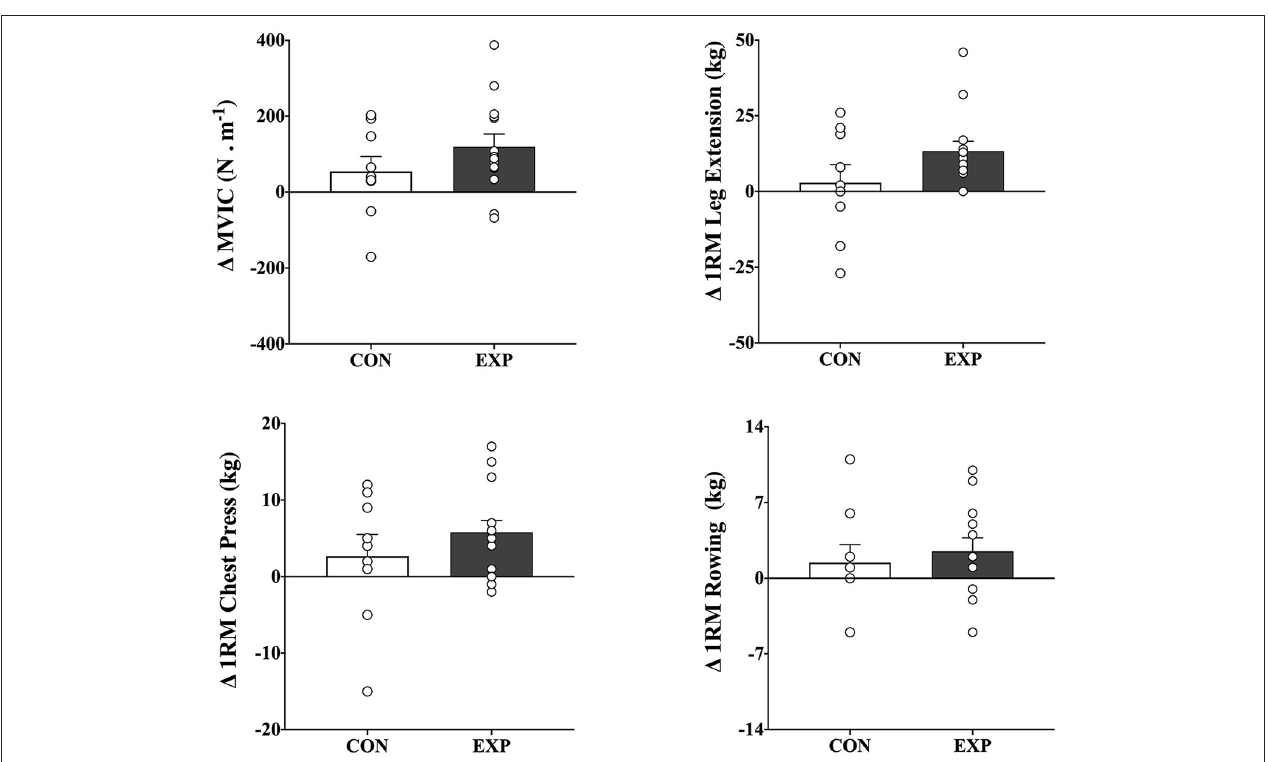
FIGURE 2 | Mean and individual change scores in maximal voluntary isometric contraction (MVIC; top left ), 1 RM leg extension ( top right ), 1 RM chest press ( bottom left ), and 1 RM seated row ( bottom right ) after combined endurance and resistance training for both control ( CON ; n = 9) and experimental ( EXP ; n = 9) groups. The values are post- minus pretraining (means ± SEM ). There were no significant differences between groups.